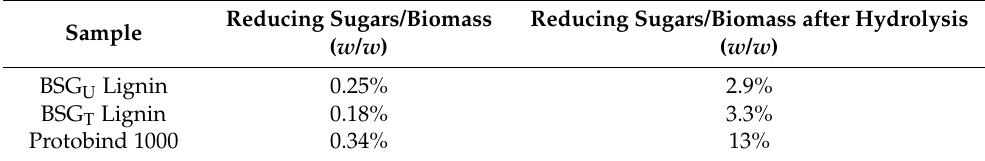
Table 5. Results of the total reducing sugar quantification. Sample